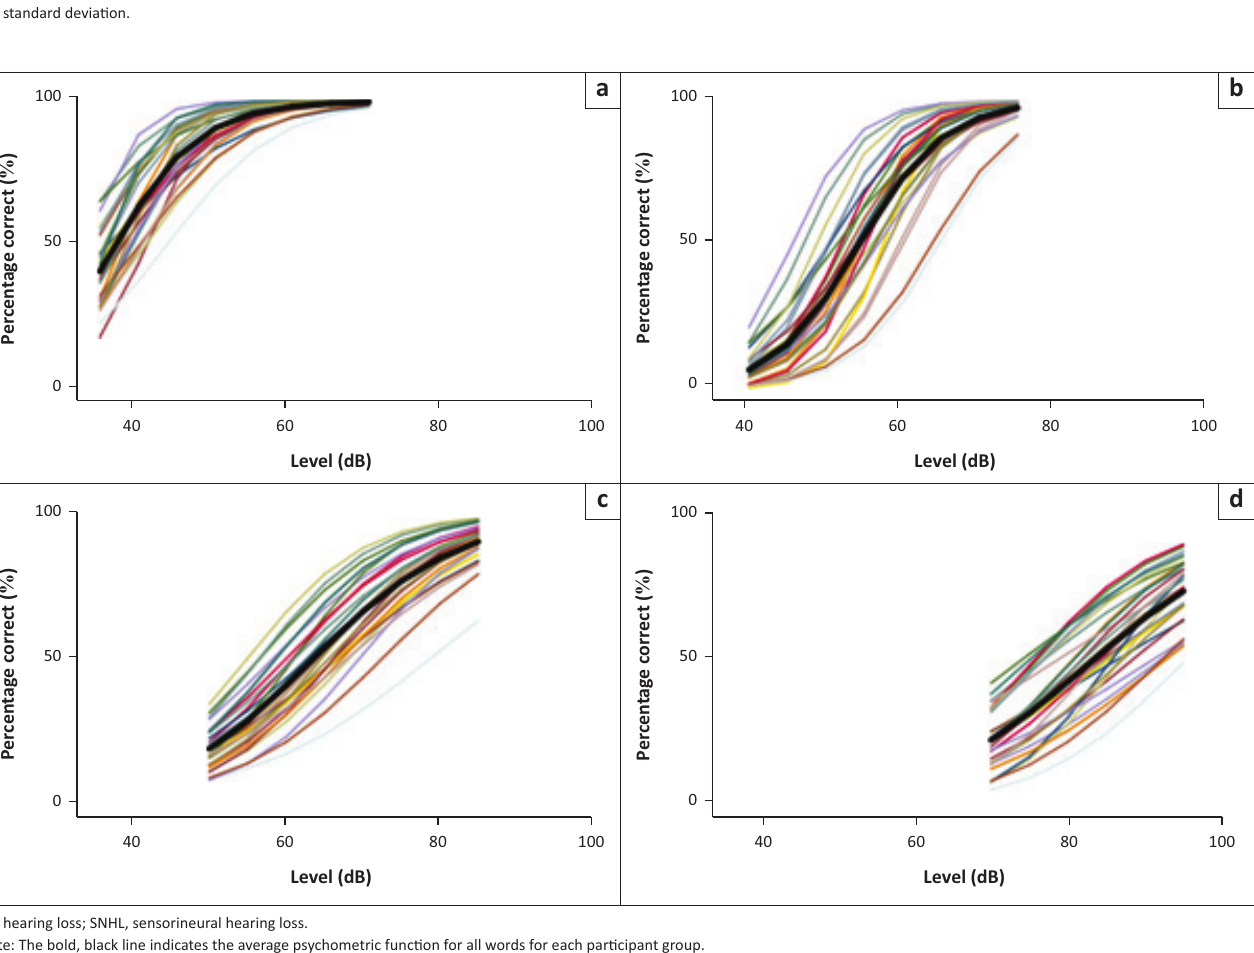
FIGURE 1: The psychometric functions for each of the 28 words in the zSRT speech reception threshold test, for each participant group by degree of hearing loss: (a) mild conductive hearing loss (b) moderate conductive hearing loss (c) moderately severe SNHL (d) Severe